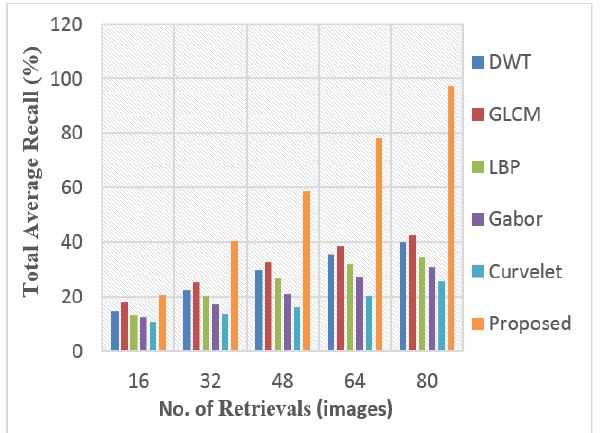
Table 2. Performance of the proposed system